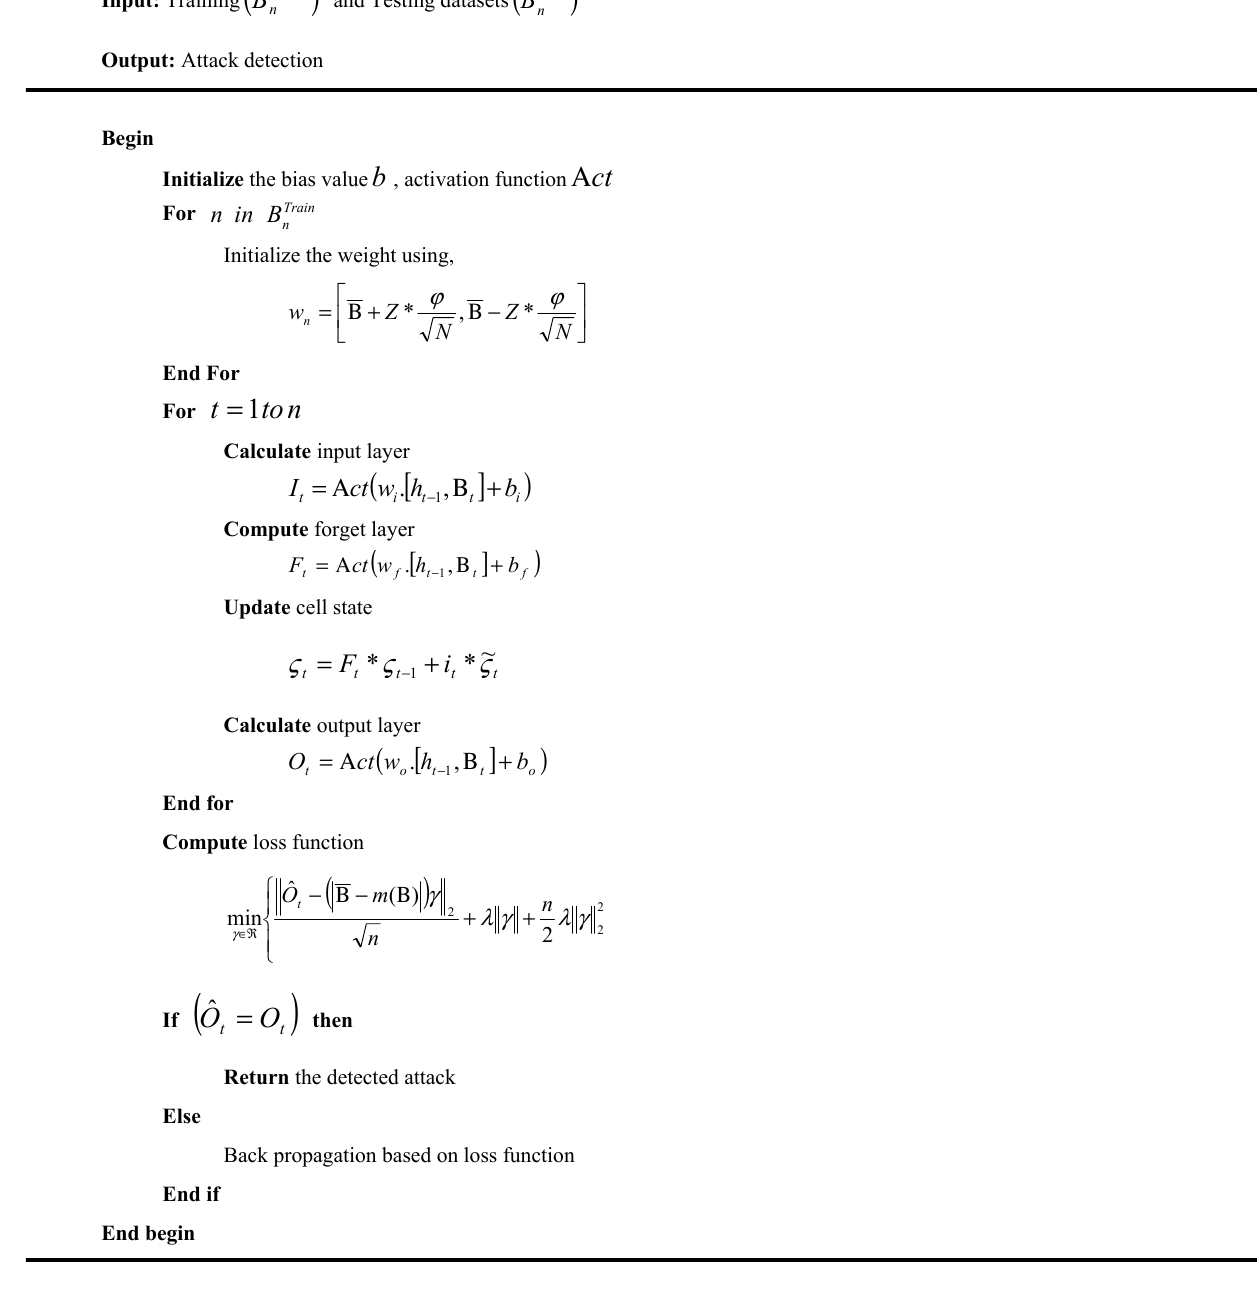
Figure 3. Pseudo code for proposed HT-RLSTM.